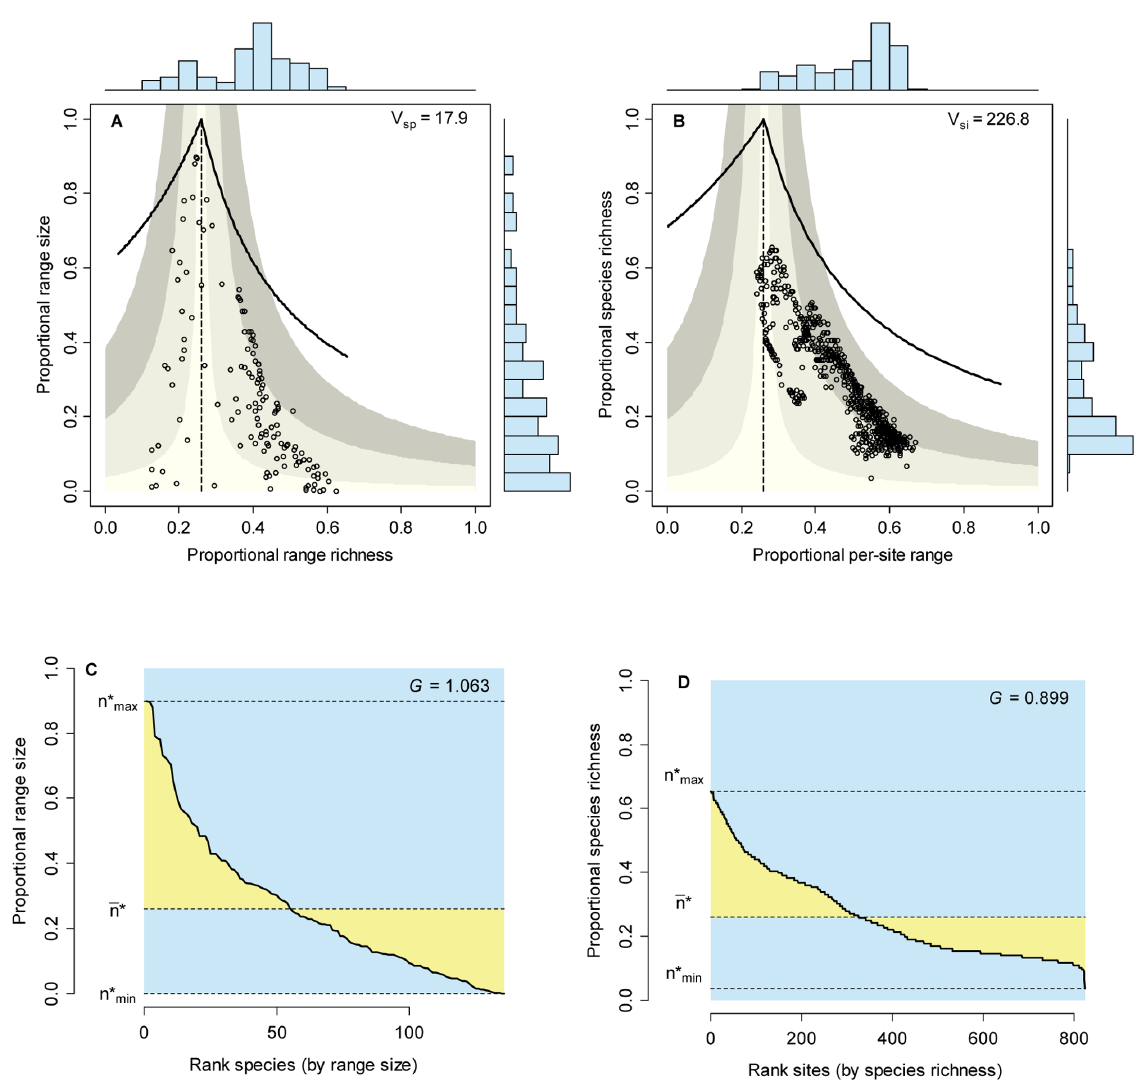
Figure 7. Range-diversity and rank plots for the set of Mexican bats. Information on RD plots (A and B) as in Figure 2A and B; information on rank plots as in Figures 1, 2C, and